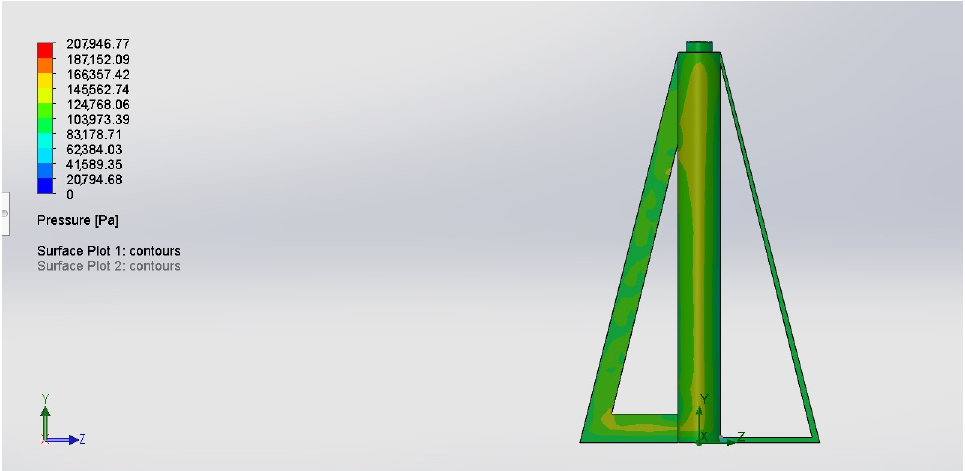
Figure 18. Result of pressure simulation (back view).